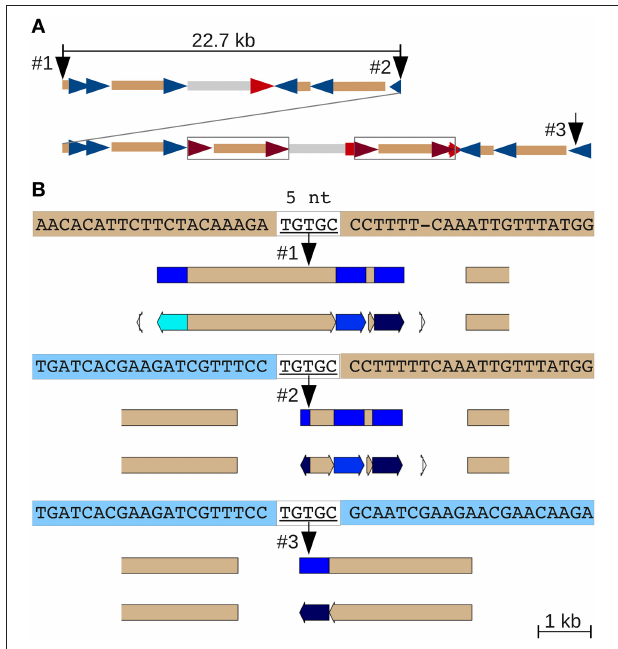
FIGURE 4 | Alternative end-joining in the formation of an adjacent segmental duplication. (A) Overview of the duplication. A 22.7 kb fragment consisting of several nested and partial CR1s, a CR2 solo LTR and a genomic repeat (gray) was duplicated locally (Figure S3D). Two full-length CR2 elements subsequently inserted into the downstream duplication (boxed). CR1 LTRs blue, CR2 LTRs red and CDS tan. (B) A 5 nt match between the polyprotein coding region at the 5 ′ end of the initial 22.7 kb fragment (top sequence) and the CR1 LTR (represented by the 3 ′ end of the duplicated region, bottom sequence) likely mediated this tandem duplication by alternative end-joining DNA repair following a double-strand DNA break. JV annotations: CR1 LTRs blue, CDS